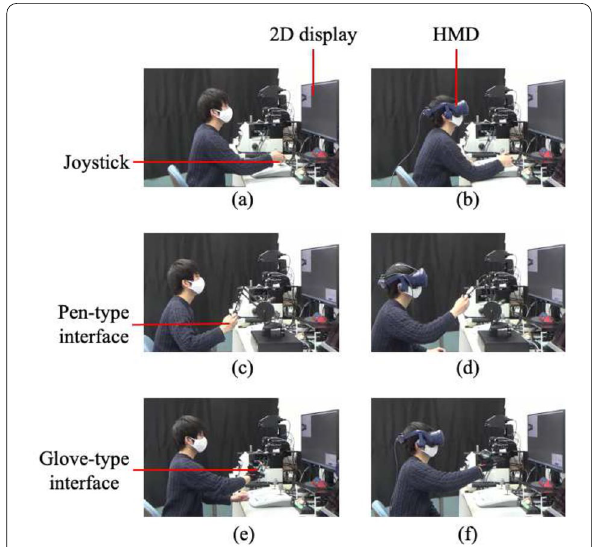
Fig. 12 Subjects in each conditions